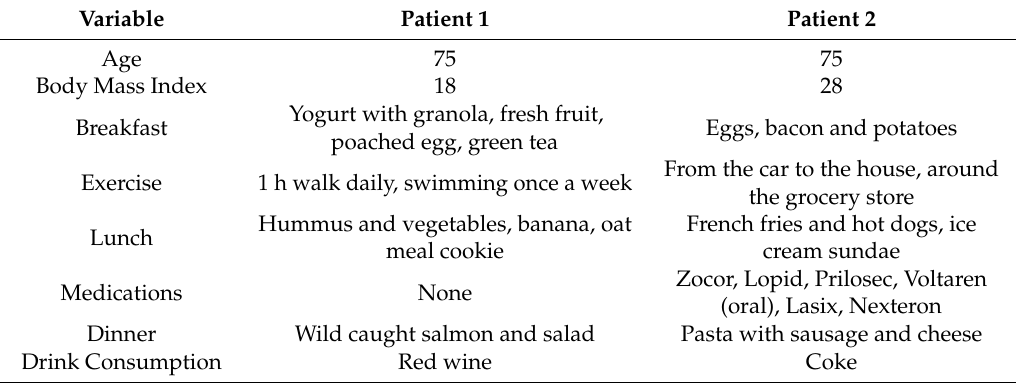
Table 3. Comparison of two geriatric